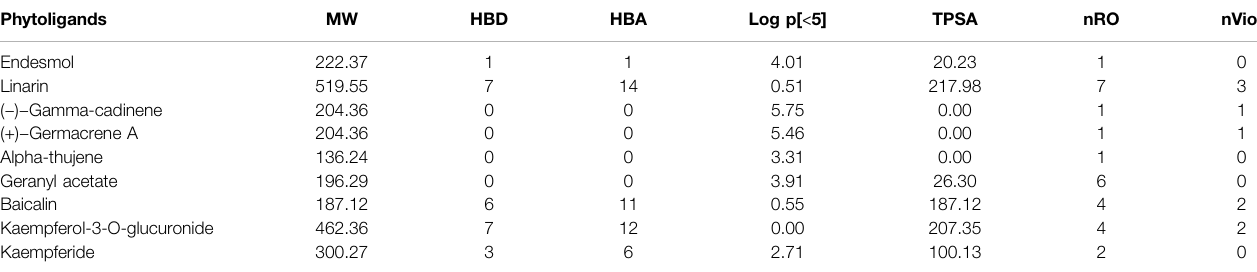
TABLE 3 | In silico drug-likeness and molecular property prediction in top three hit phytochemicals from each of the three selected plants ( Mentha arvensis , Coriandrum sativum , and Ocimum tenui fl orum ). Phytoligands